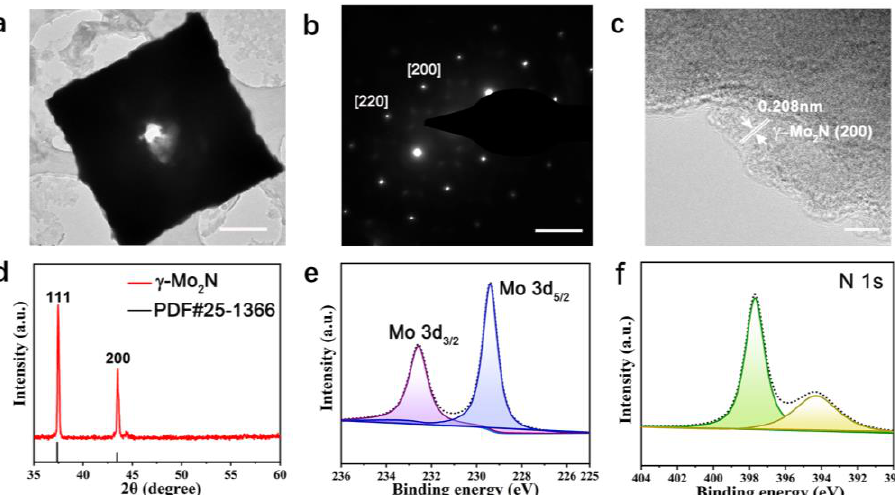
Figure 3. Characterizations of as-prepared γ -Mo 2 N crystals. ( a ) TEM image of γ -Mo 2 N crystal. The scale bar is 1 μm. ( b ) SAED pattern of γ -Mo 2 N crystal. The scale bar is 5 1/nm. ( c ) HRTEM showing γ -Mo 2 N crystal is single-crystalline. The scale bar is 5 nm. ( d ) XRD pattern of γ -Mo 2 N and the corresponding JCPDS file results. ( e,f ) XPS spec tra of Mo 3d and N 1s for γ -Mo 2 N crystals.